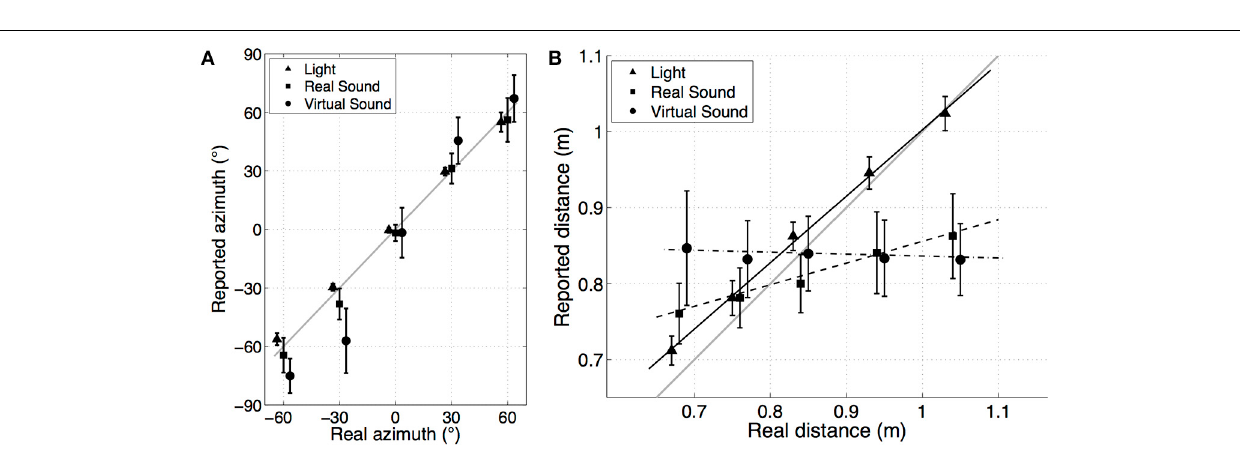
FIGURE 4 | (A) Mean of all subjects’ reported azimuth as a function of stimuli azimuth for each rendering condition: visual ( (cid:2) ), real sound ( (cid:3) ), and virtual sound ( • ). Error bars show one standard deviation across the subjects. Gray line shows unity. (B) Mean of all subjects’ reported distance as a function of